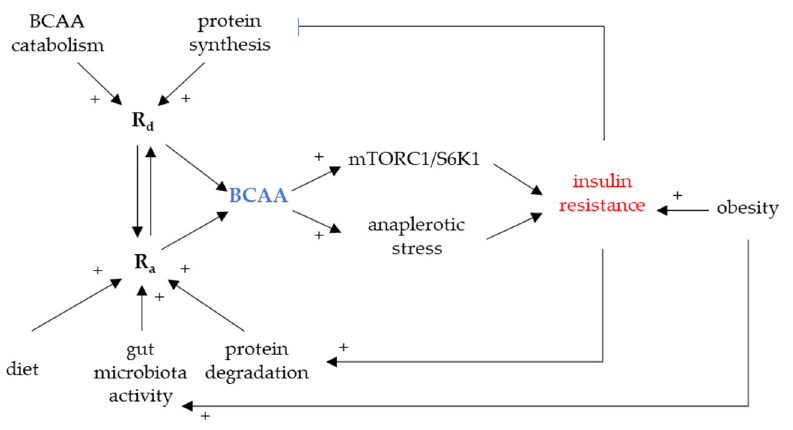
Figure 2. BCAA and insulin resistance development. mTORC1, mammalian/mechanistic target of rapamycin complex 1; R a , rate of appearance; R d , rate of disappearance; S6K1, p70S6 serine kinase 1.